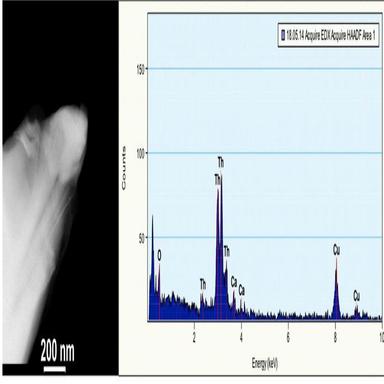
Image (HAADF) and EDS spectra from the third high-Z particle extracted from the slag material.